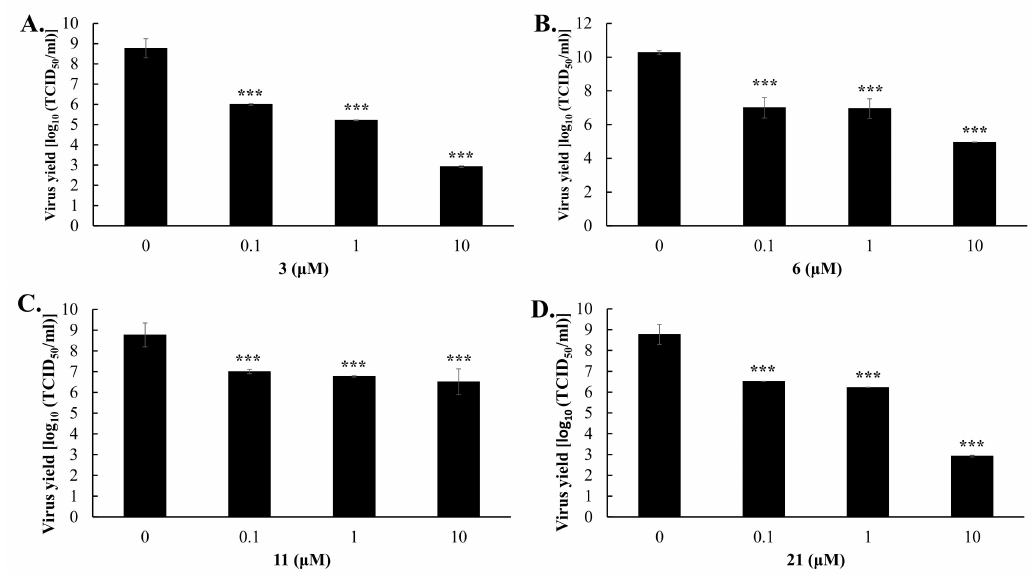
Figure 4. Reduction of DENV2 yield in Vero E6 cells by Compounds 3, 6, 11, and 21. Vero E6 cells were infected with DENV2 in the presence and absence of Compounds 3 ( A ), 6 ( B ), 11 ( C ), and 21 ( D ) at concentrations of 0.1, 1, and 10 µ M, respectively. Virus yield in the cultured media of treated/infected Vero E6 cells was analyzed 96 h post-treatment by TCID50 assay. *** p value < 0.001 compared with untreated infected